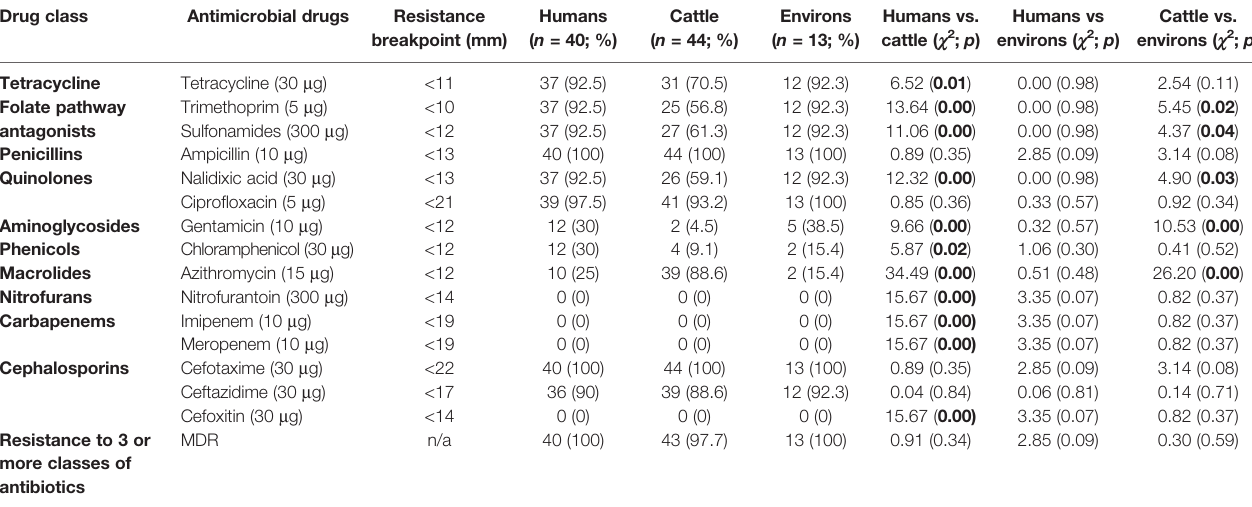
TABLE 1 | Antimicrobial resistance pro fi les of ESBL-EC isolates from abattoir workers, beef cattle, and abattoir environments in Abuja and Lagos — Nigeria. Drug class Antimicrobial drugs